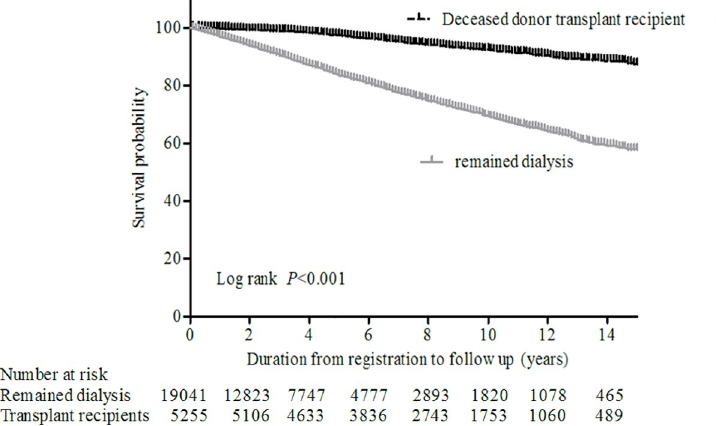
Fig 1. Kaplan-Meier plots comparing overall survival in patients with deceased donor kidney transplants with those who remained dialysis. The survival curves were compared using the log rank test (p < 0.001).